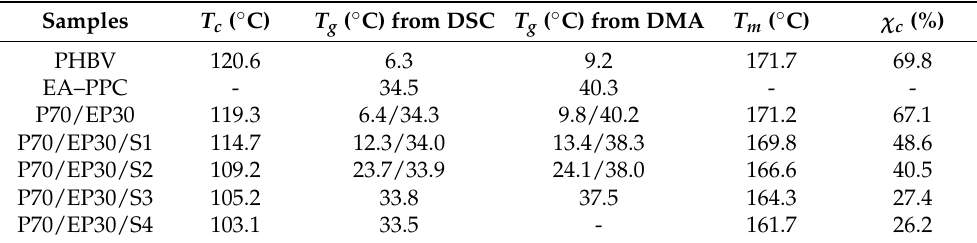
Table 3. Data for the thermal properties of PHBV/EA–PPC